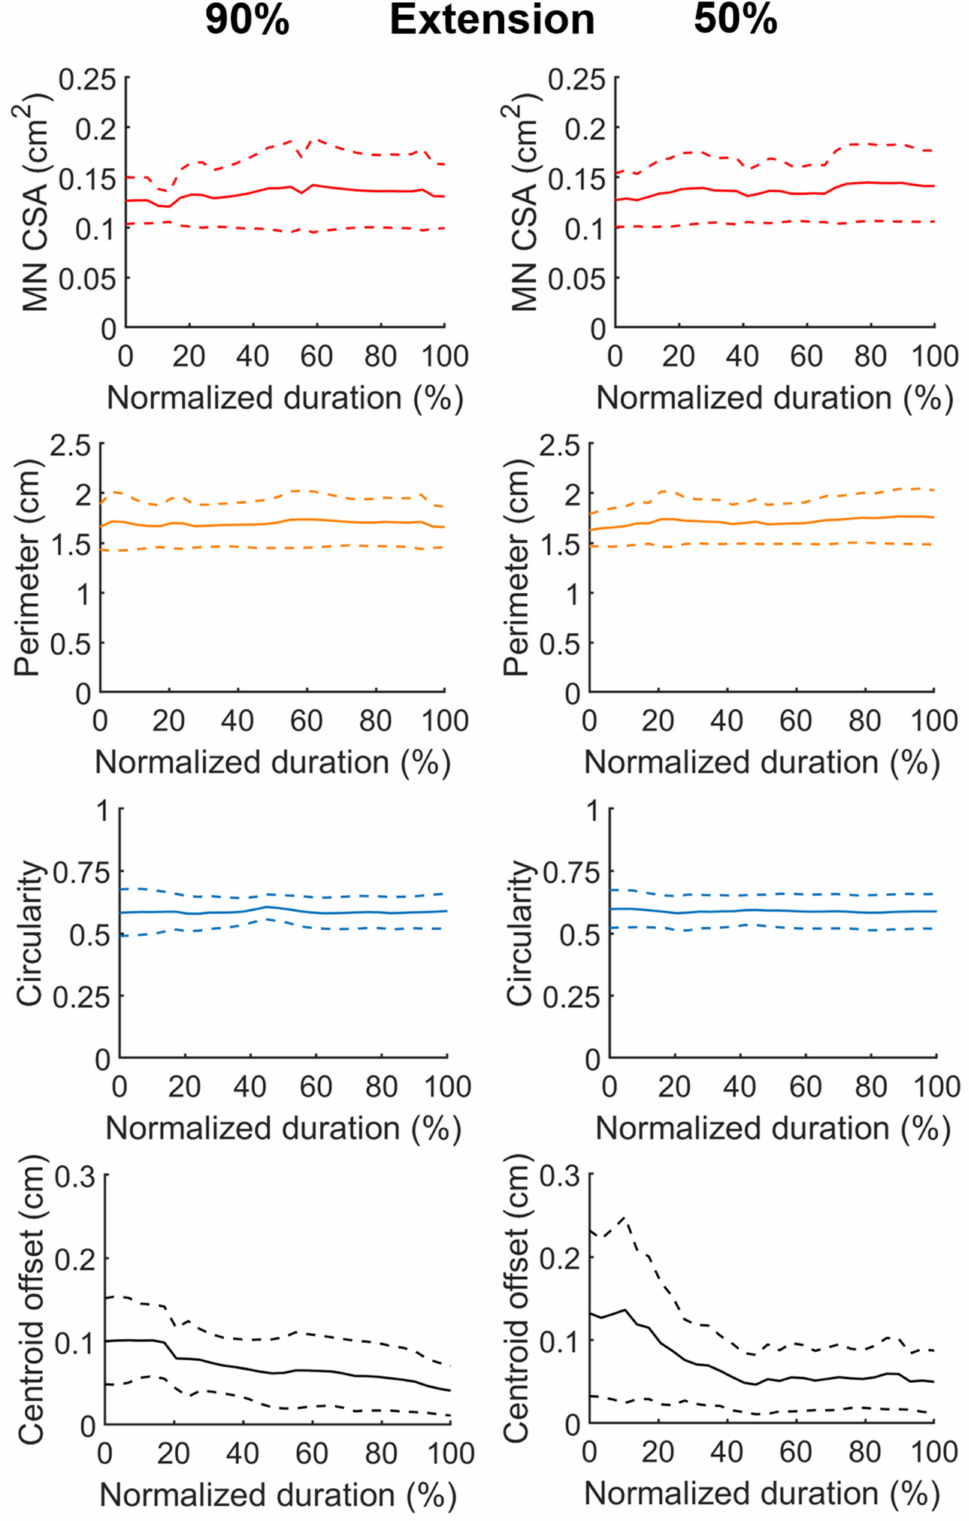
Figure 5. Temporal profiles of the morphological characteristics of inferred MNs during fingers extension, including the CSA and the perimeter of the nerve, the MN circularity, and the centroid displacement throughout the motion. The phase duration was rescaled by normalization. The data shown in the left and right columns were pooled from the data of duration confined by the D 90 and D 50 defined in Figure 3, respectively. In the individual panel, the solid line represents the average of the resampled data, and the dash lines stand for average plus and minus one standard deviation,